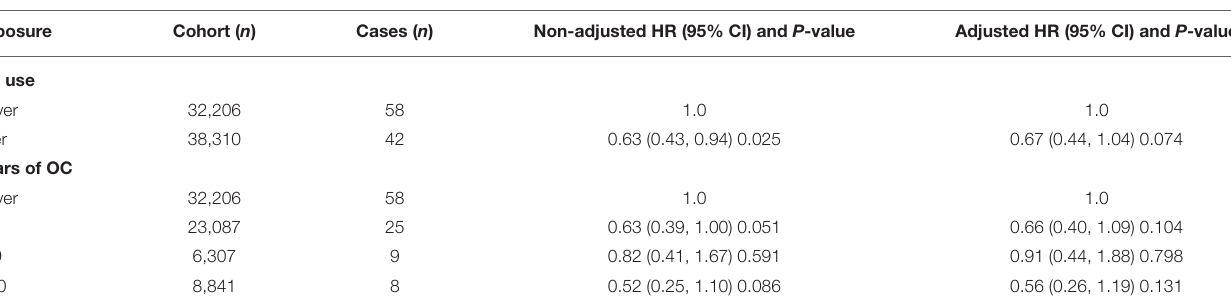
TABLE 2 | OC use and glioma risk in the PLCO